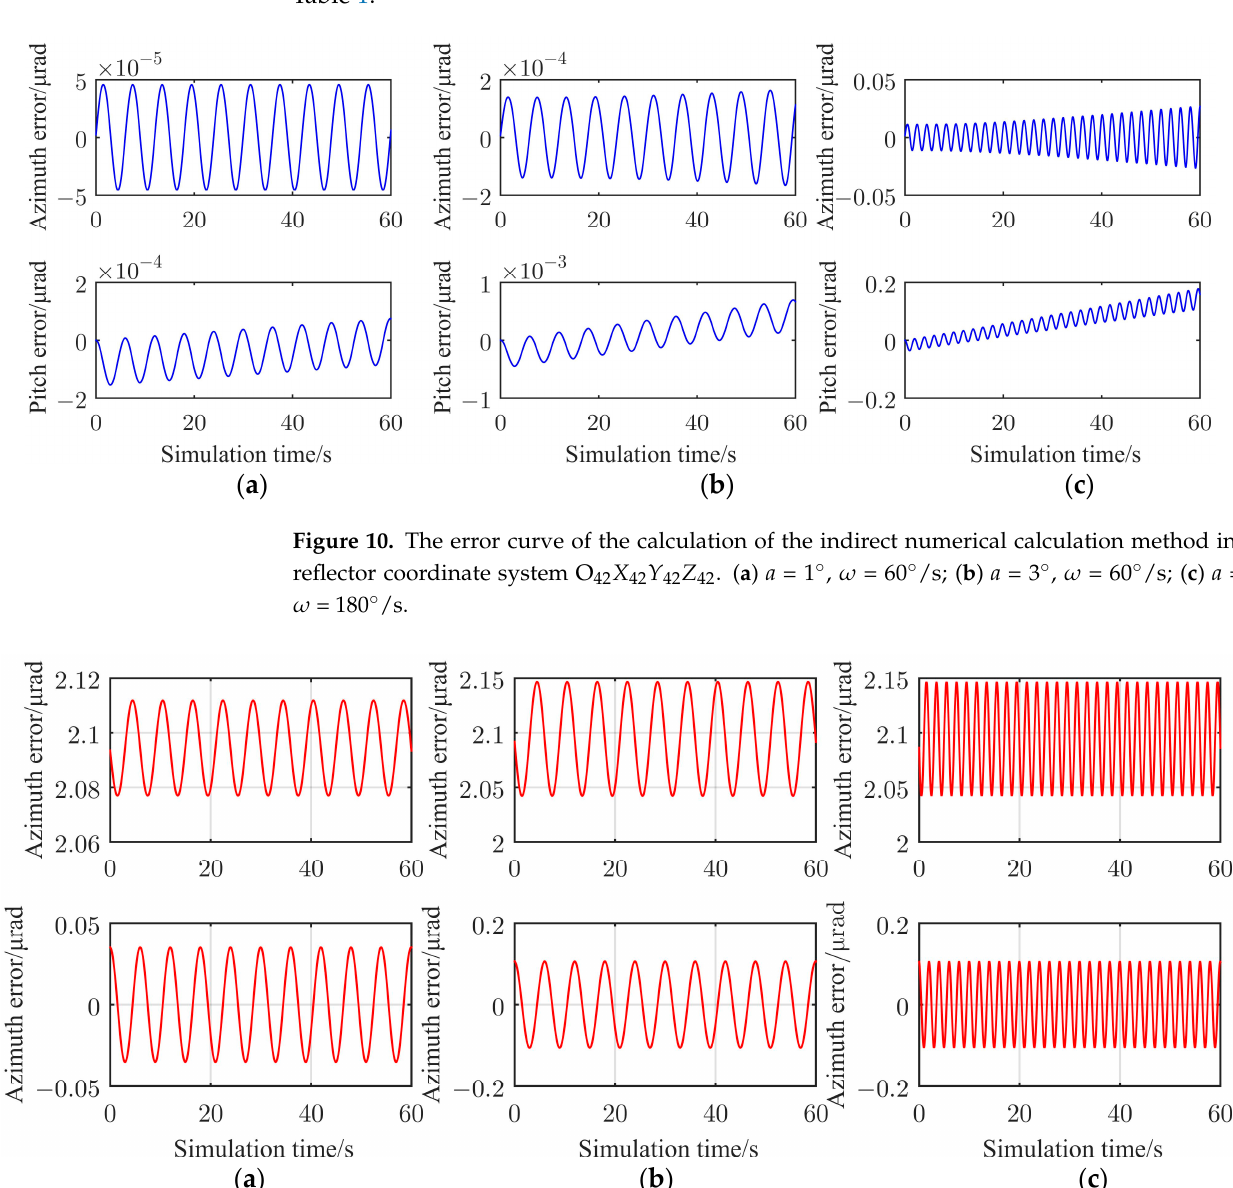
Figure 9. The LOS a tt itude curves under the condition of conical motion in an ideal state in the